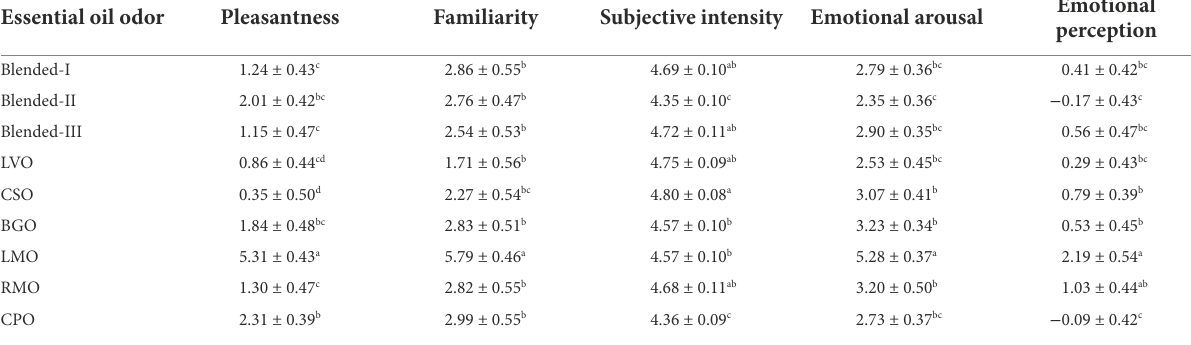
TABLE 4 Sensory evaluation of different oil odor. Essential oil odor